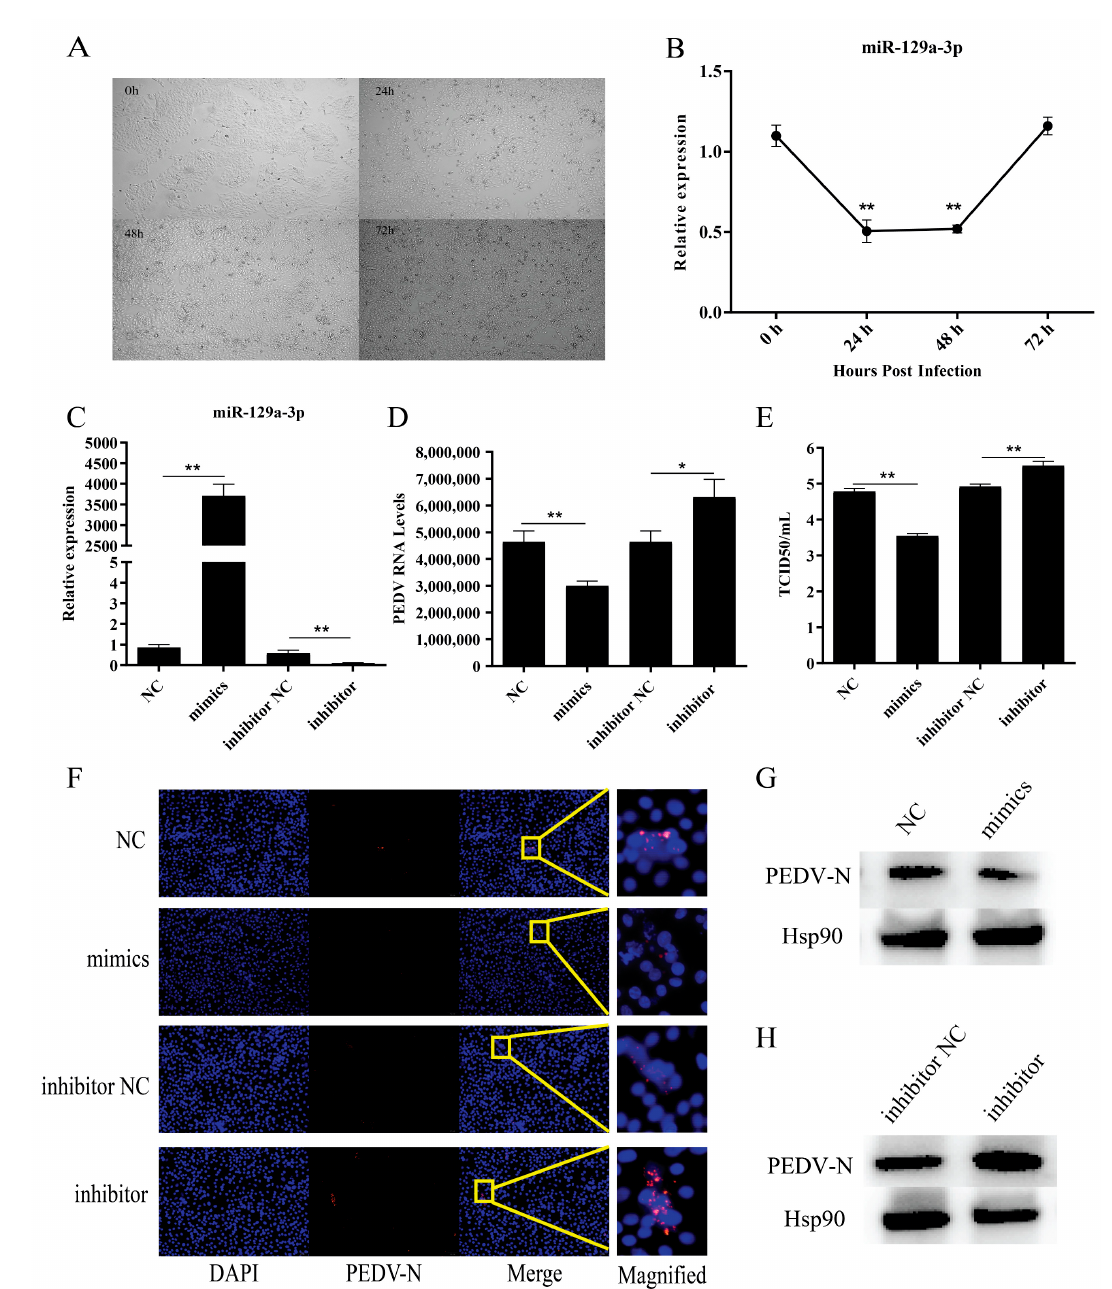
Figure 1. Effect of miR-129a-3p on PEDV viral replication. ( A ) Cell morphology at different time points in IPEC-J2 cells infected with PEDV. ( B ) Analyzing miR-129a-3p expression after PEDV infection. ( C ) Validation of miR-129a-3p mimics and inhibitor efficiency. ( D ) Differential analysis of PEDV copy number in cells infected with PEDV with different treatments. ( E ) Analysis of TCID50 results of cells infected with different treatment groups by PEDV. ( F ) Effects of different treatments on PEDV replication. ( G ) Expression levels of PEDV protein after PEDV infection of cells treated with miR-129a-3p mimics. ( H ) Expression levels of PEDV protein after PEDV infection of cells treated with miR-129a-3p inhibitor. The * denotes a significant difference with p < 0.05, while the ** denotes a significant difference with p < 0.01.